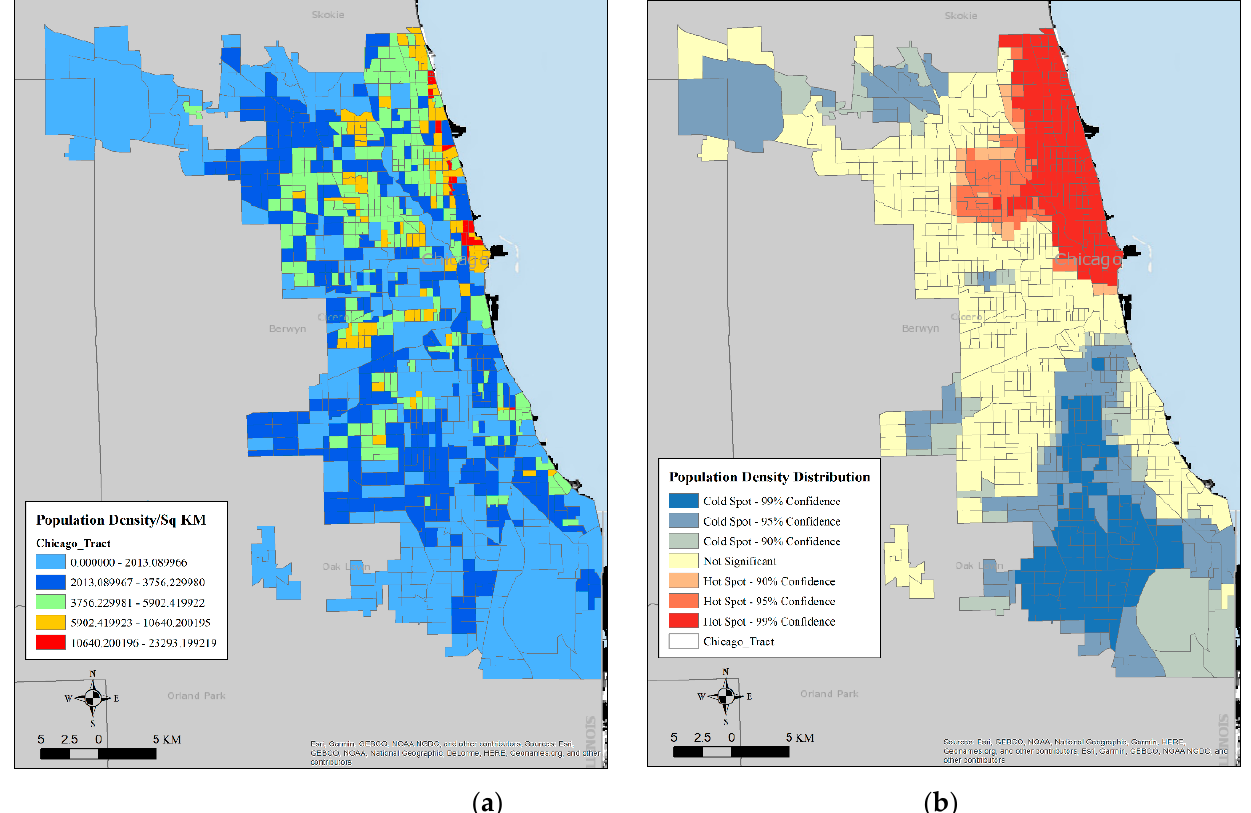
Figure 3. Population density distribution at census tract in Chicago (population/square KM) ( a ) and high- and low-density census tract clusters in Chicago ( b ).